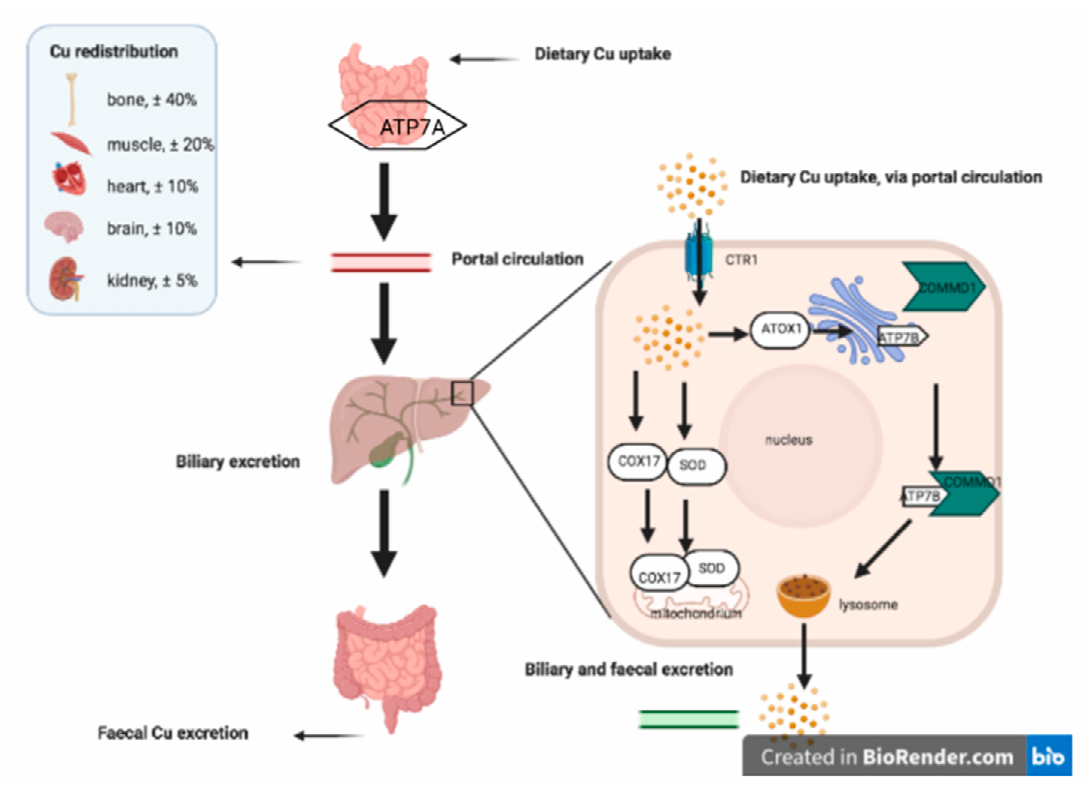
Figure 1. Dietary intake, hepatic homeostasis, and distribution between various organs of copper. Upon dietary intake of copper, ATP7A in the intestines facilitates release into the portal circulation and subsequent uptake in the liver and other organs. Hepatic import is mediated by CTR1 (blue), copper flows along the arrows; either via COX17 and/or SOD into the mitochondria, or via ATOX1 to the Trans Golgi Network (purple). Here, ATP7B interacts with COMMD1 (green) for proper trafficking to the lysosomes (brown), which release ceruloplasmin bound copper the copper for biliary and fecal excretion. Abbreviations: ATOX1, Antioxidant protein1; ATP7A, P-type ATPase 7A; ATP7B, P-type ATPase 7B; CCS, Copper Chaperone for Superoxide Dismutase; COMMD1, COpper Metabolism Murr1 domain-containing protein 1; COX17, Cytochrome c Oxidase Copper Chaperone; CTR1, Copper TRansporter 1; SOD, Superoxide Dismutase.